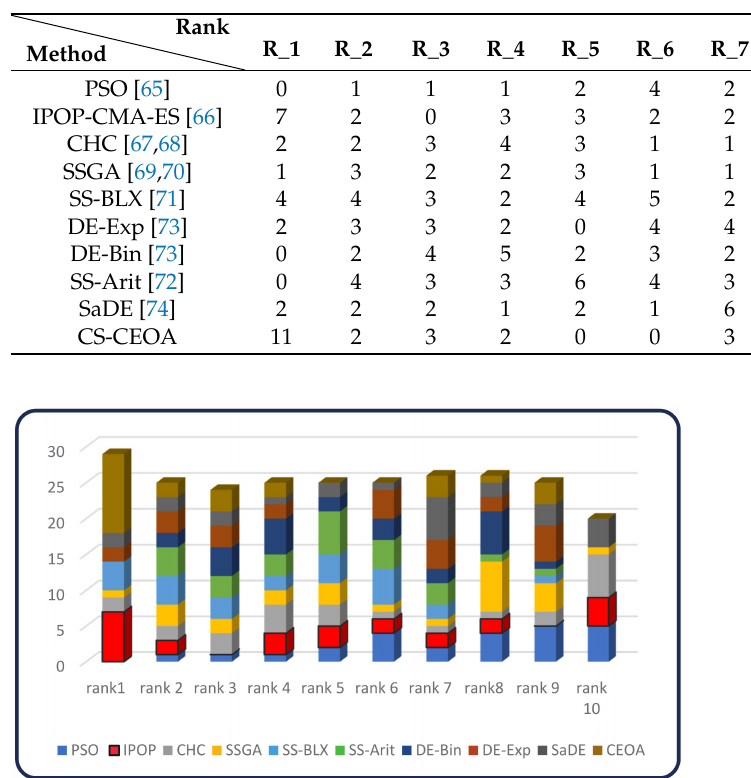
Figure 3. The relative weight of each algorithm by